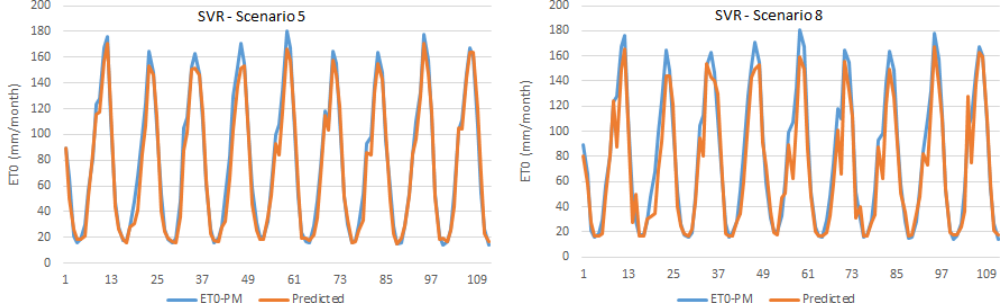
Figure 7. Time series graphics of SVR-estimated and FAO56PM-estimated ET 0 in scenarios 5 and 8.